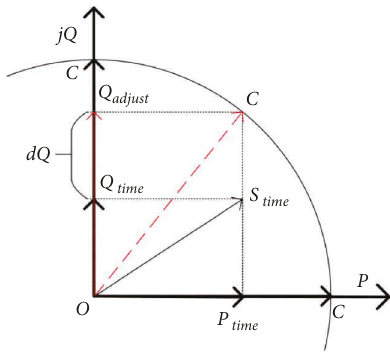
Figure 5: RPC power vector diagram.